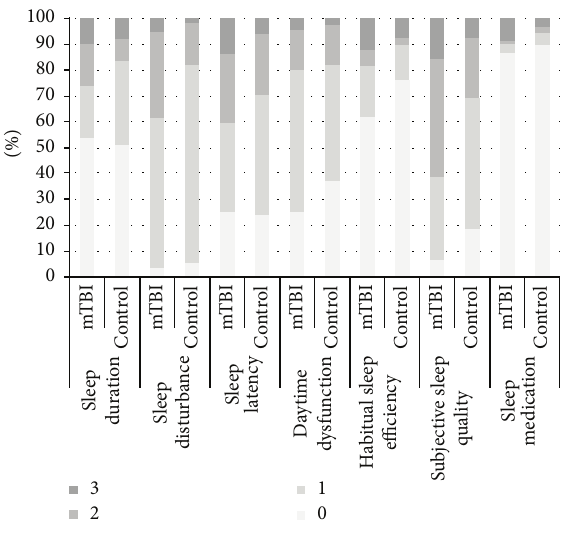
Figure 1: Percentage of each score for seven sleep